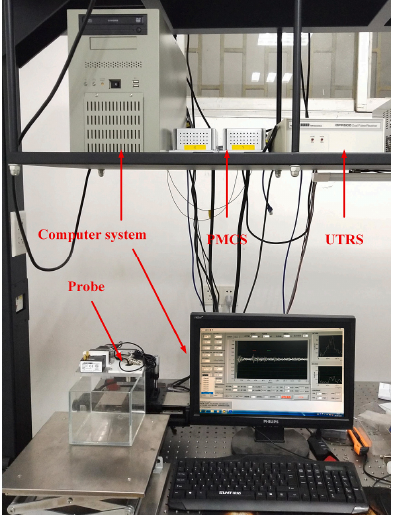
Figure 2. The detected circumferential weld: ( a ) the side view of the mockup; ( b ) the cross-section view of the mockup.